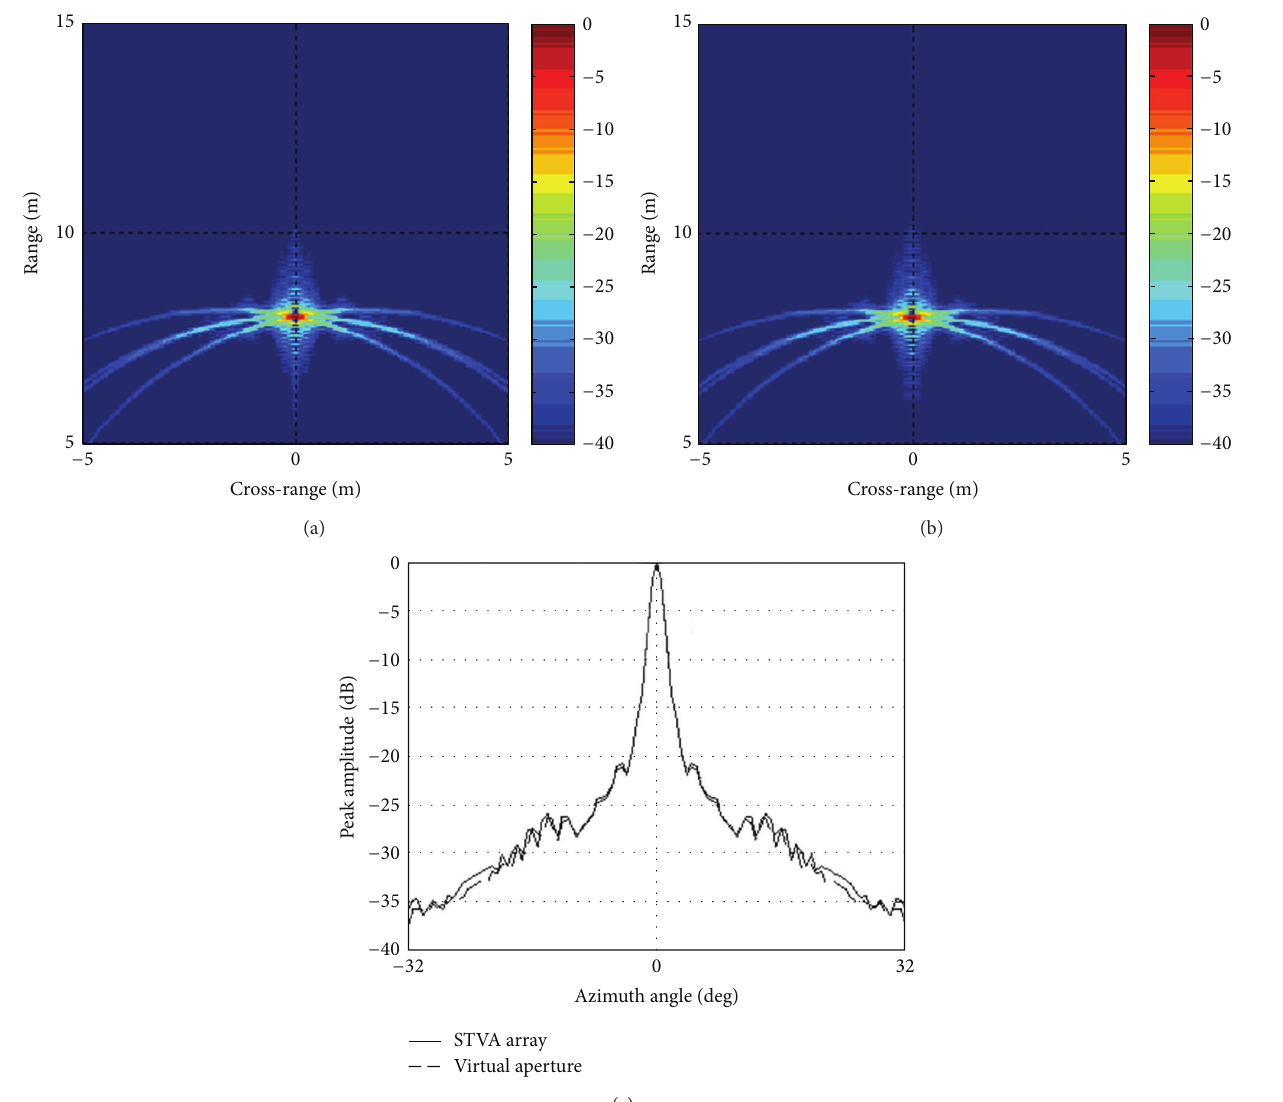
Figure 4: Comparison of the PSFs between the STVA array and its virtual array with focal point at 8m. (a) STVA array. (b) Virtual array. (c) Peak amplitude pattern in azimuth